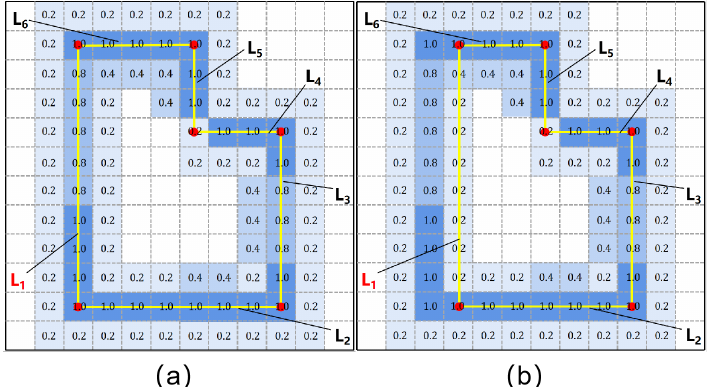
Figure 6. Illustration of the E pix term, which is defined by edge likelihood maps. The energy value is calculated from the pixels that the edge passes through. The energy value in ( a ) is less than the energy value in ( b ).